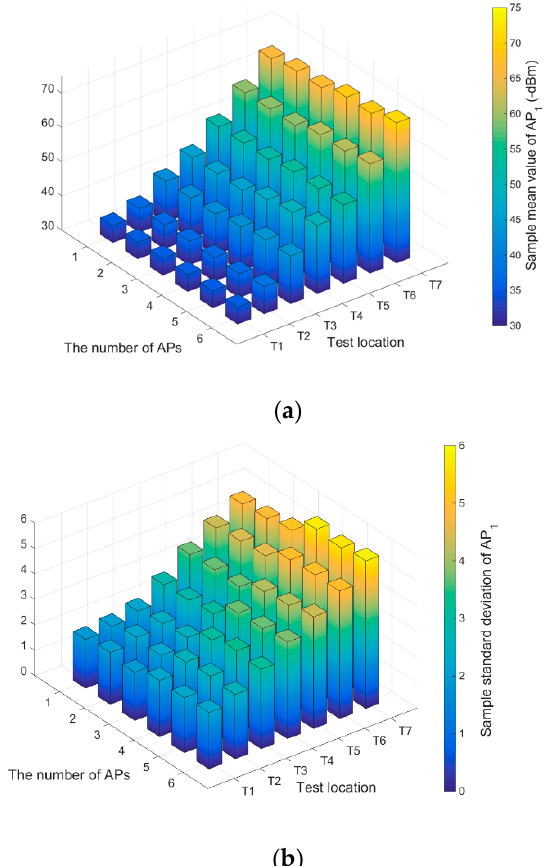
Figure 4. The RSS statistics from AP 1 at different numbers of APs and different test locations in a tunnel: ( a ) Mean value of AP 1 ; ( b ) Standard deviation of AP 1 .